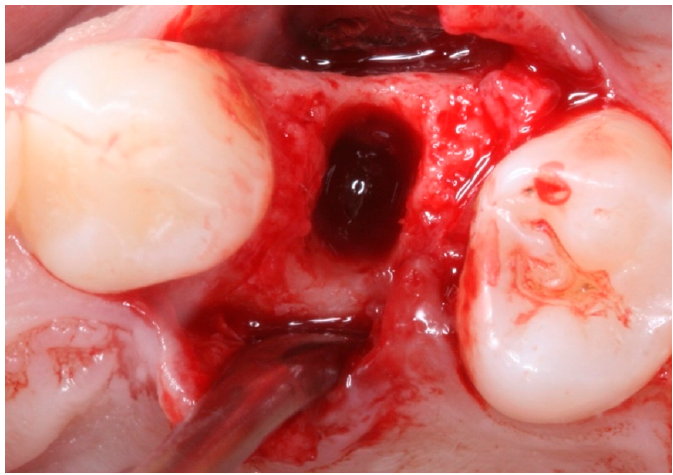
Figure 6. Intraoral occlusal preoperative view of the region of toot 24.